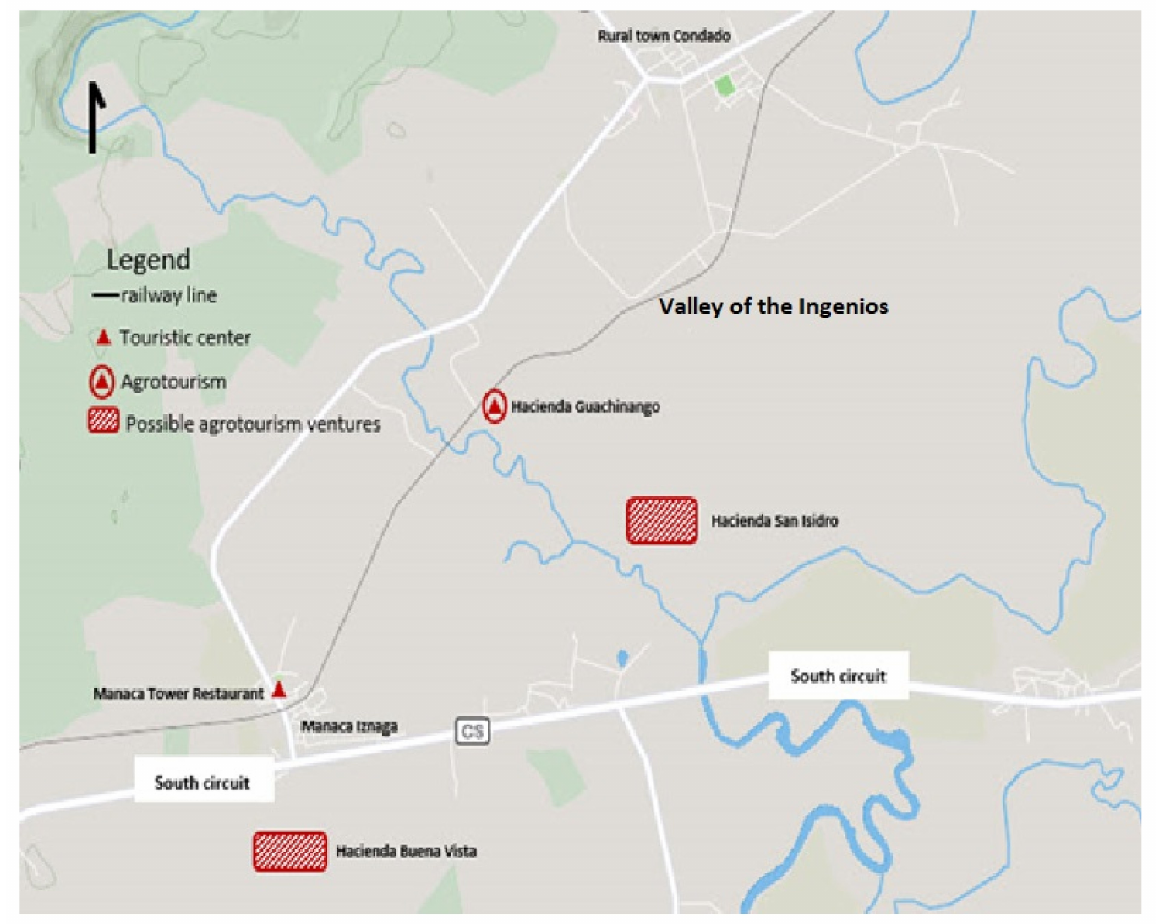
Figure 1. Location of Hacienda Guachinango. Source: own elaboration from